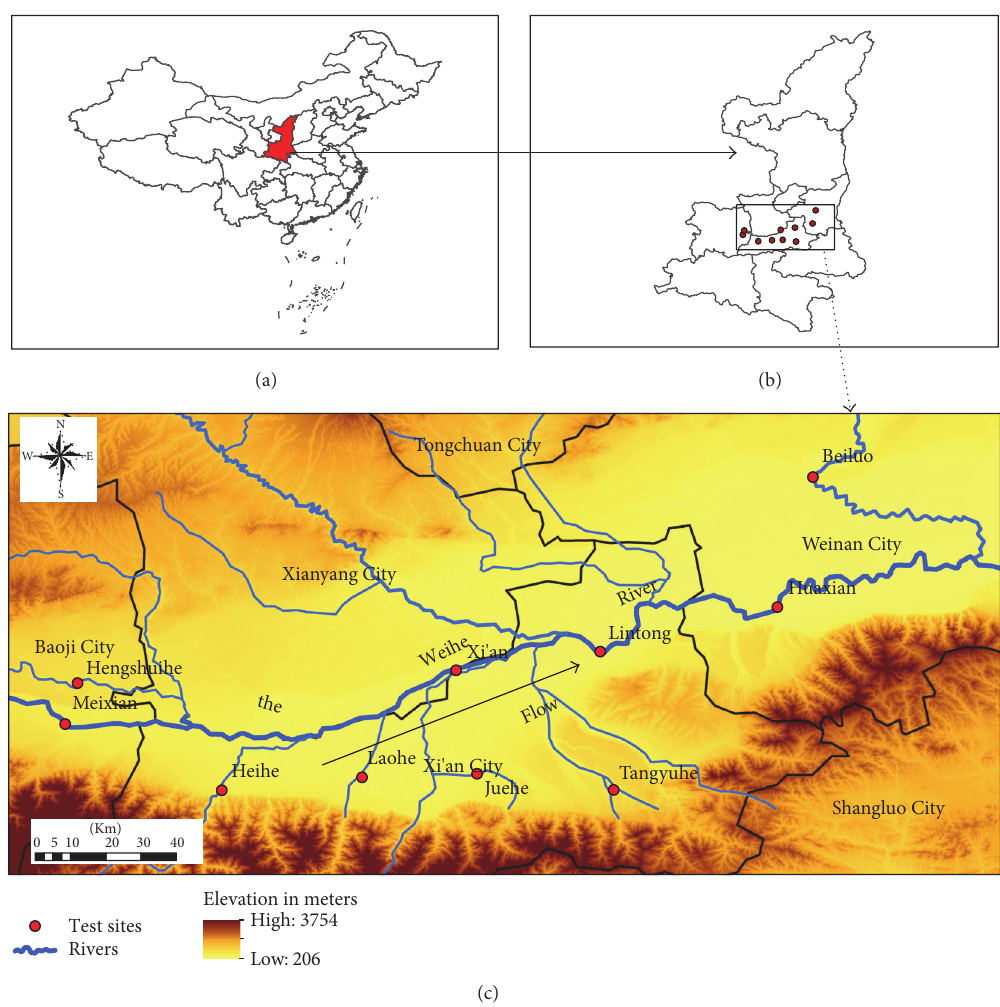
Figure 2: Location map of testing sites in this study.